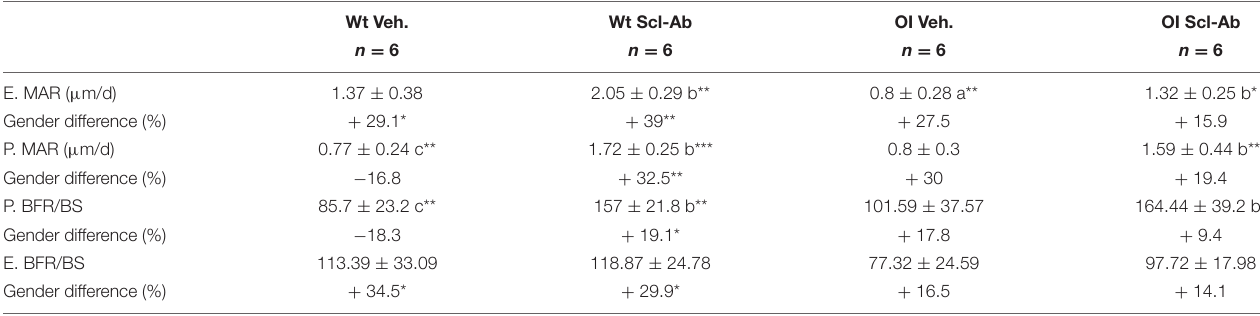
TABLE 5 | Midshaft periosteal (P) and endocortical (E) mineral apposition rate (MAR) and bone formation rate per bone surface (BFR/BS, mm 3 /mm 2 per year) of the tibia in male wild-type (Wt) and oim/oim (OI) mice after 9-week treatment with either Scl-Ab or vehicle (Veh.). Wt Veh. Wt Scl-Ab OI